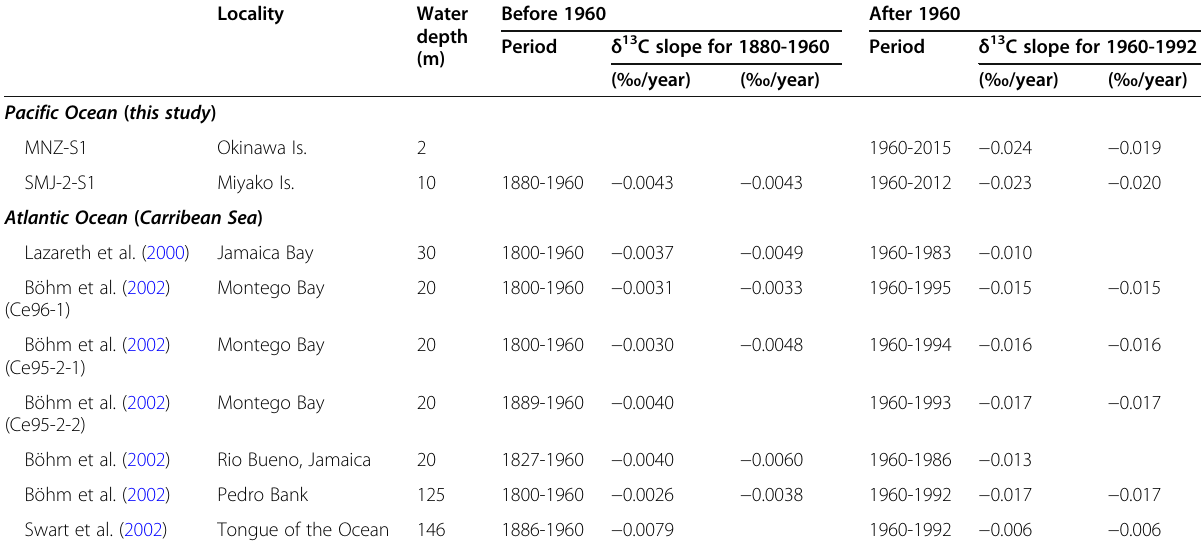
Table 1 Decreasing trends estimated from sclerosponge δ 13 C records since 1800 Locality